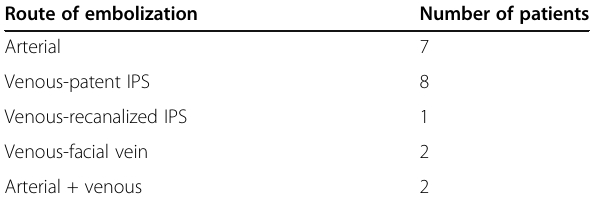
Table 2 Different approaches used for embolization Route of